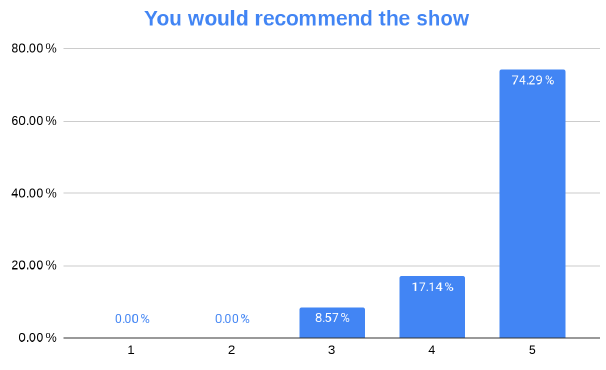
Figure 8. Plot showing the audience percentage recommending the